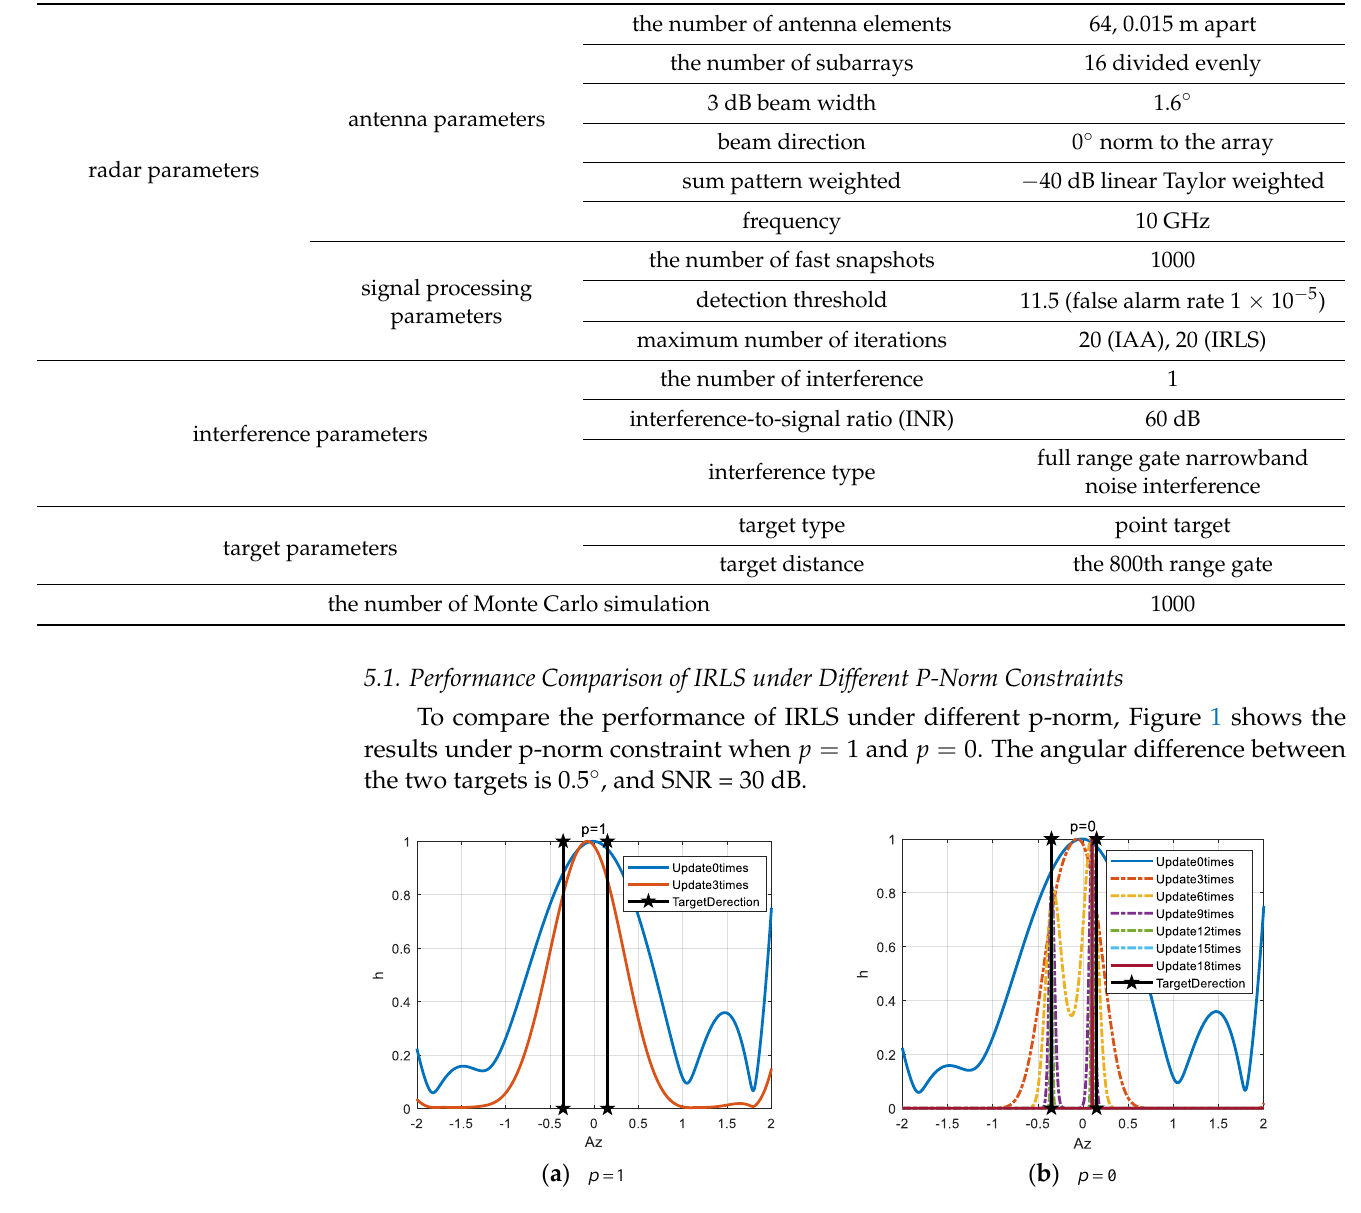
Figure 1. Comparison of IRLS under different p-norm constraints.